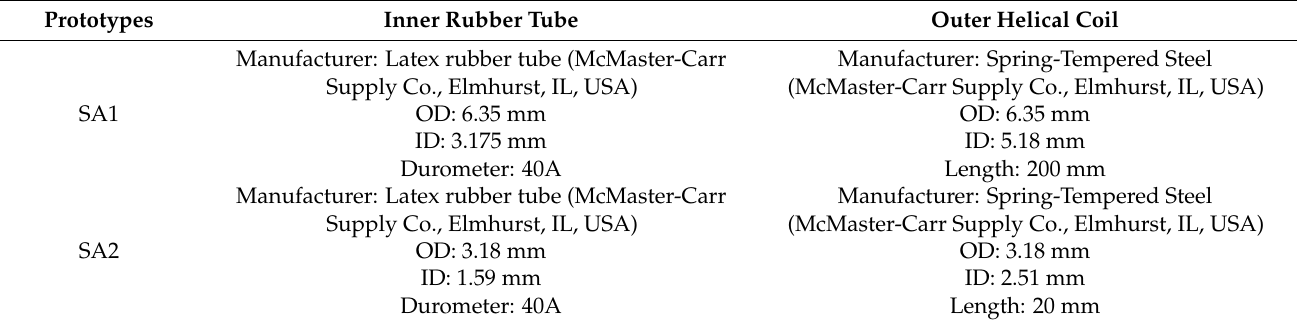
Table 1. Physical properties of the SAs used in